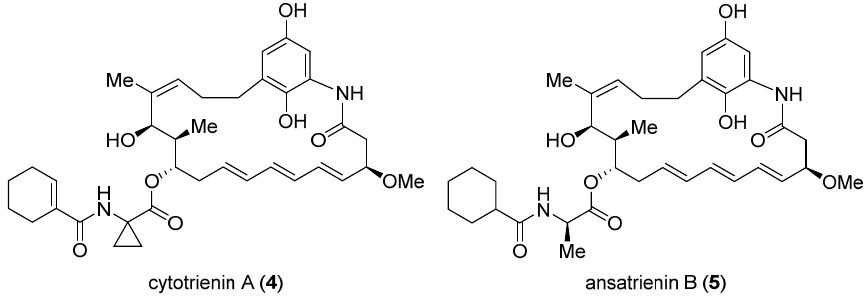
Figure 2. Structures of cytotrienin A ( 4 ) and ansatrienin B ( 5